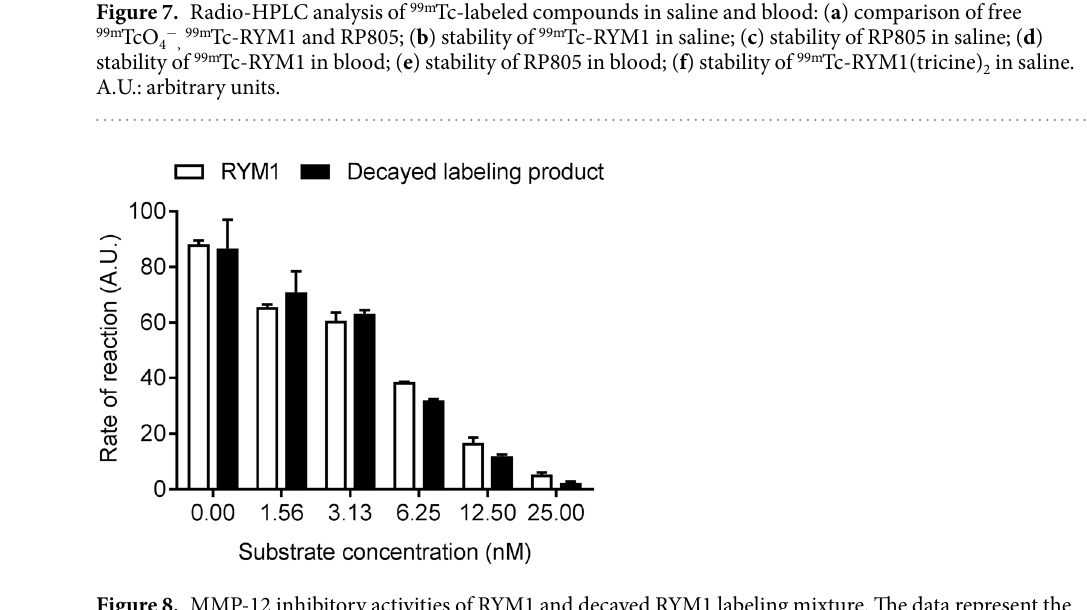
Figure 8. MMP-12 inhibitory activities of RYM1 and decayed RYM1 labeling mixture. The data represent the mean ± SD of duplicate determinations. A.U.: arbitrary